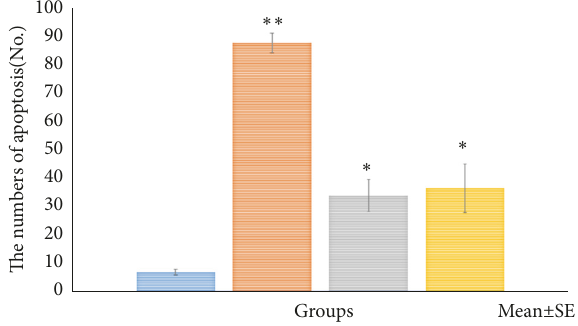
Figure 14: The number of cells undergoing apoptosis after elec- trochemical therapy in 24hr after treatment. The distribution of apoptosis of the tumor. Quantitation was performed as described in the text and the distribution of apoptotic bodies expressed in relation to position on the tumor cells. Significantly different ∗ p < 0.05 , ∗∗ p < 0.01 , control vs. 10mA × 150sec, 10mA × 300sec, and 10mA × 600sec. The results represent ± S.D. from 8 to 10